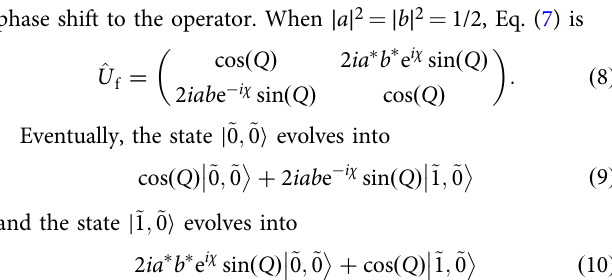
Fig. 2 Results of the relevant time-dependent Schrödinger equation. a The pendular ground j ~ 0 ; ~ 0 i (solid line) and excited ~ 1 ; ~ 0 populations at the peak t peak of the two-color pulse, and b those populations after the laser pulse has passed completely at t f . The degrees of alignment c and orientation d at t peak evaluated from the pendular ground state (blue-solid line) and the mixed pendular state ψ solving the time-dependent Schrödinger equation. The results are shown as a function of the peak intensity I ω of the ω